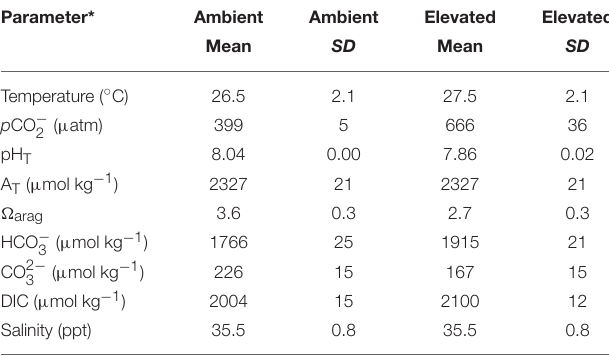
TABLE 1 | Experimental conditions of the ambient and elevated